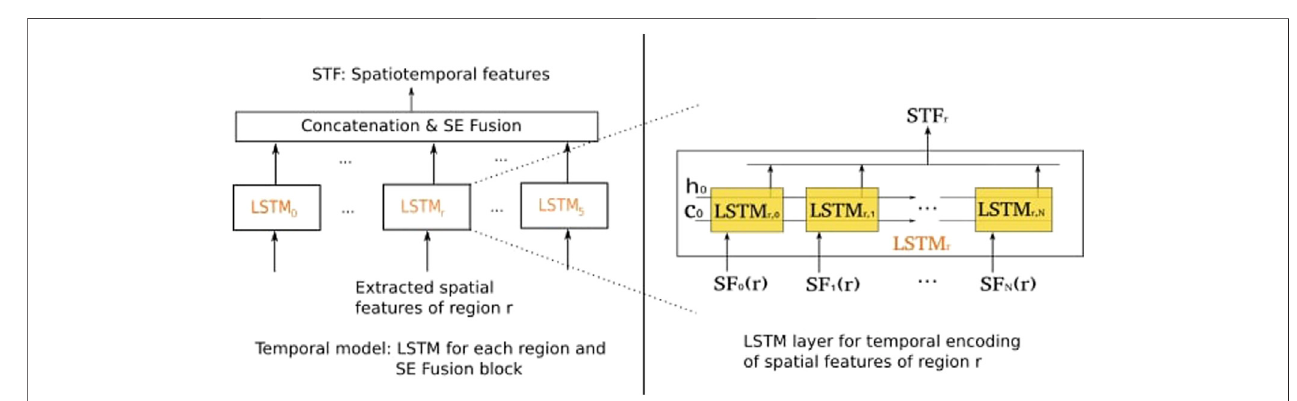
FIGURE 6 | Temporal model architecture: the LSTM is employed to extract spatiotemporal features and SE to learn attention of active regions.